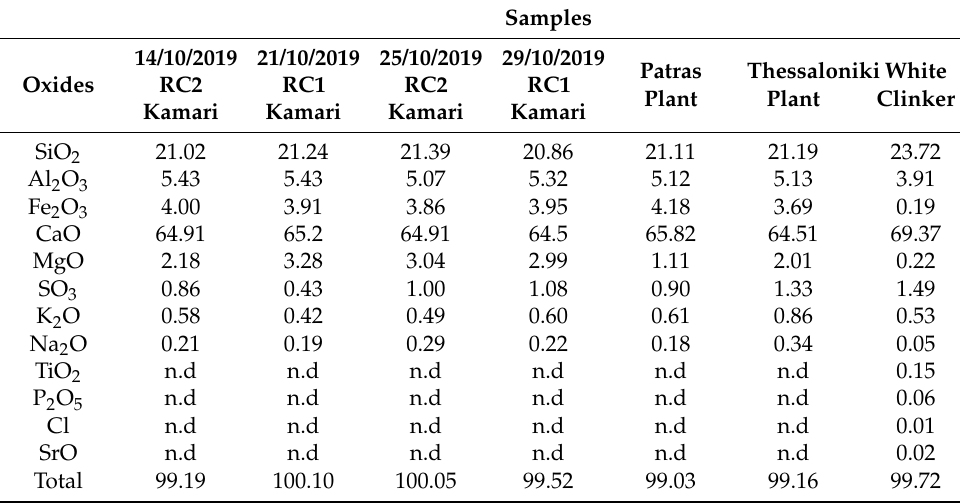
Table 2. Chemical composition of the cement clinkers. n.d = not